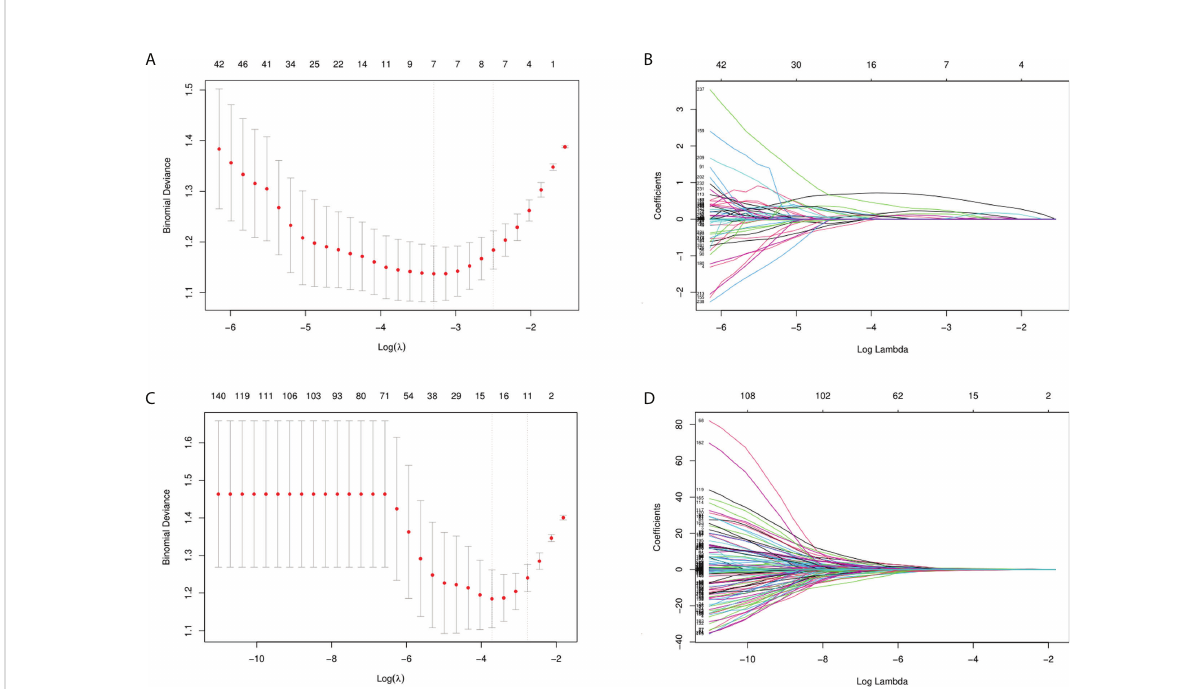
FIGURE 3 Feature selection. (A, B) Feature selection of GSUS images ( l = 0.0372, seven imaging features were selected); (C, D) Feature selection of CEUS images ( l = 0.0243, fi fteen imaging features were